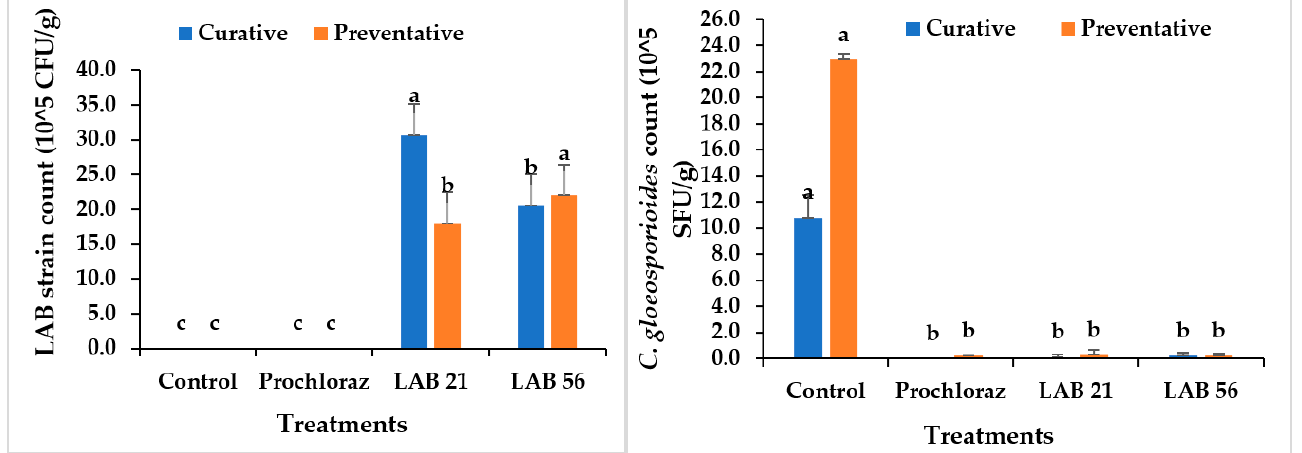
Figure 7. Recovery of LAB strains and C. gloeosporioides in curatively and preventatively inoculated avocado fruit. Similar columns with different letters were significantly different at the p ≤ 0.05 level.